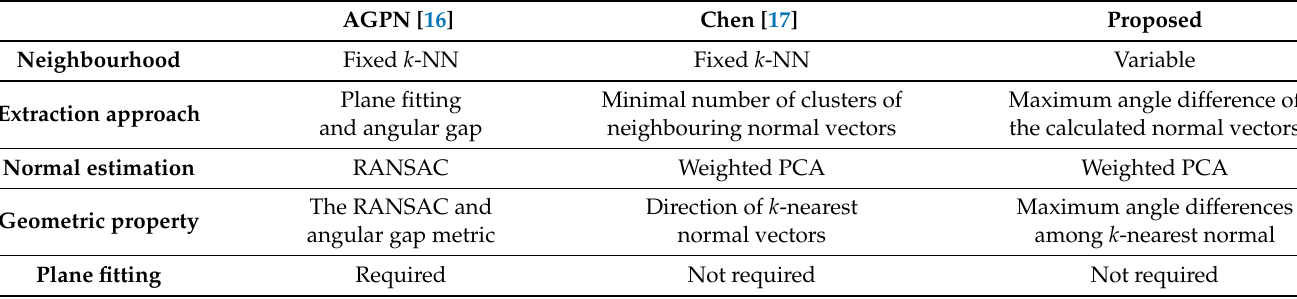
Table 3. Comparison of different methods for fold edge point